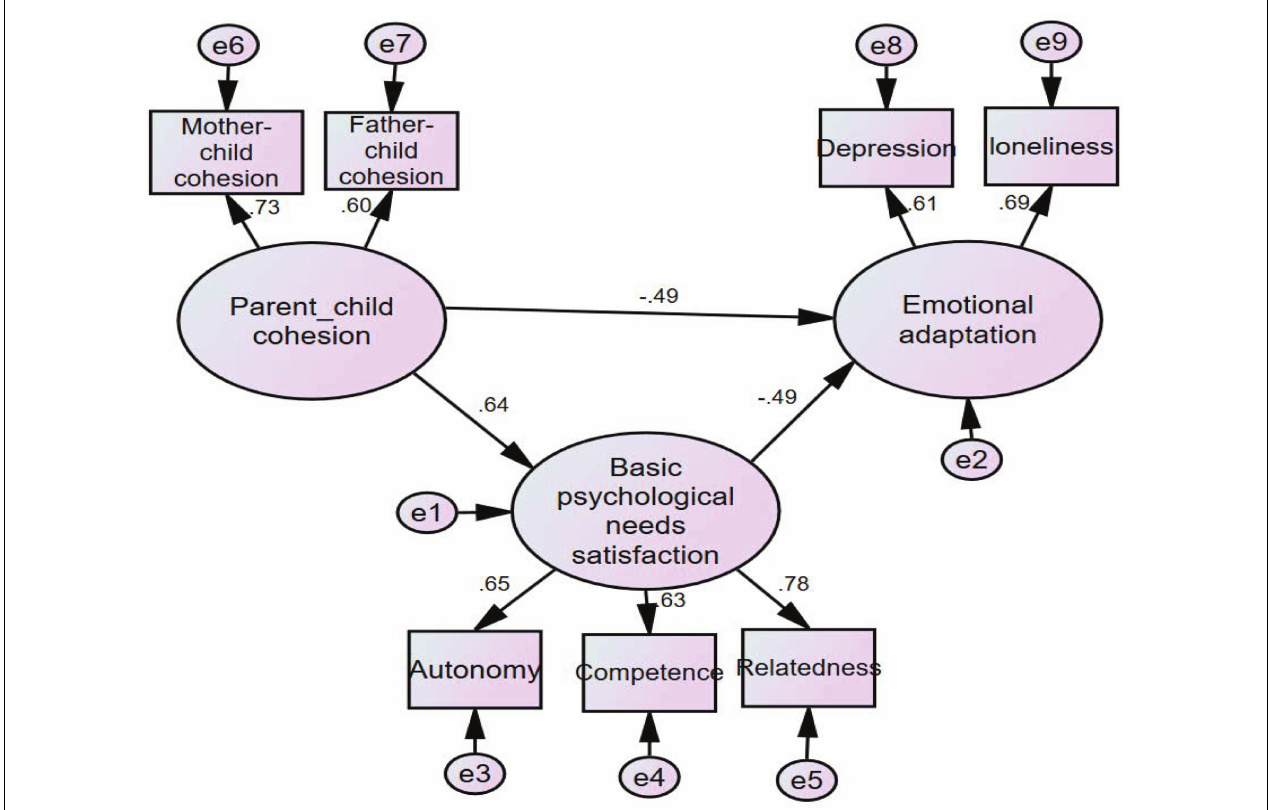
FIGURE 2 | Indirect effects model